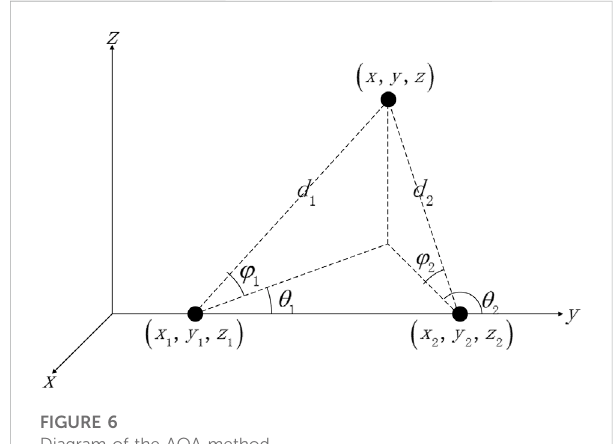
FIGURE 6 Diagram of the AOA